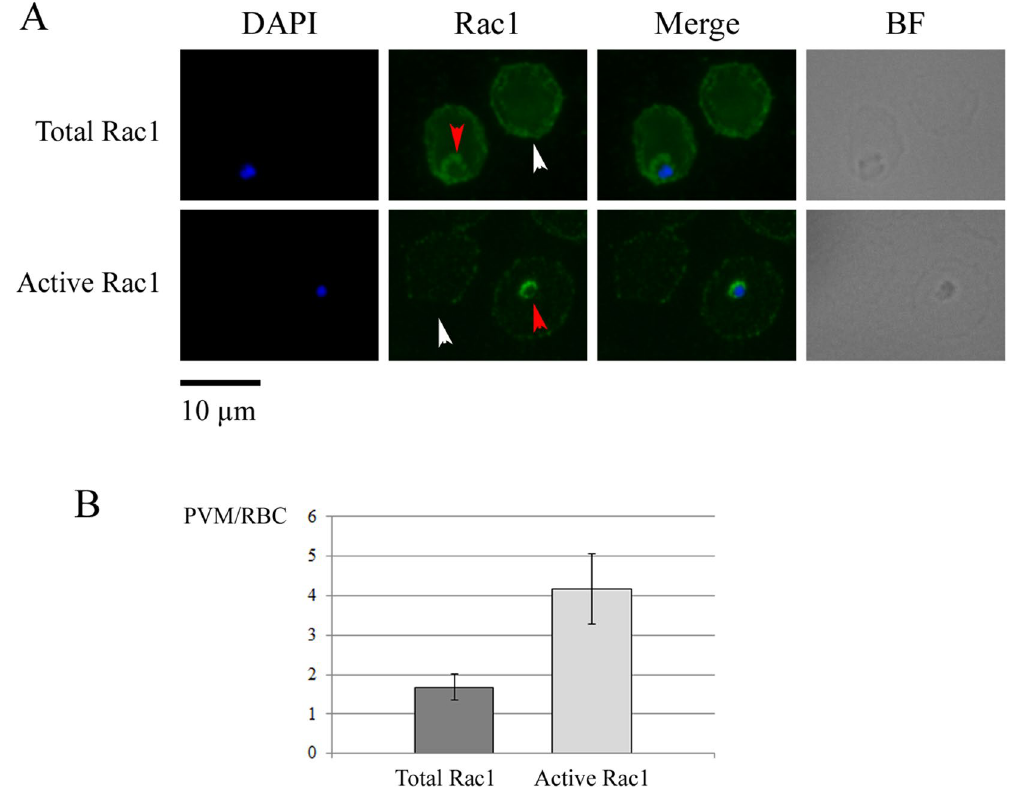
Figure 3. Rac1 activation state in infected erythrocytes. ( A ) IFA of an asynchronous parasite culture hybridized with anti-Rac1 (R1-ab#3) and anti-Rac1/GTP (R1-ab#6). BF: Bright field. Nuclei are stained with DAPI. Red arrows point at PVMs and white arrows point at non-parasitized erythrocytes. Scale bar: 10 µm. ( B ) Histogram showing the ratio between PVM and non-infected erythrocyte fluorescence, respectively with the anti-Rac1 (R1-ab#3) and the anti-Rac1/GTP (R1-ab#6). Student’s T-test: P < 10 −13